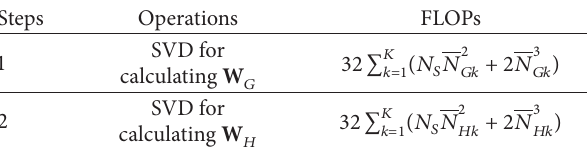
Table 1: Complexity of BD-SVD.